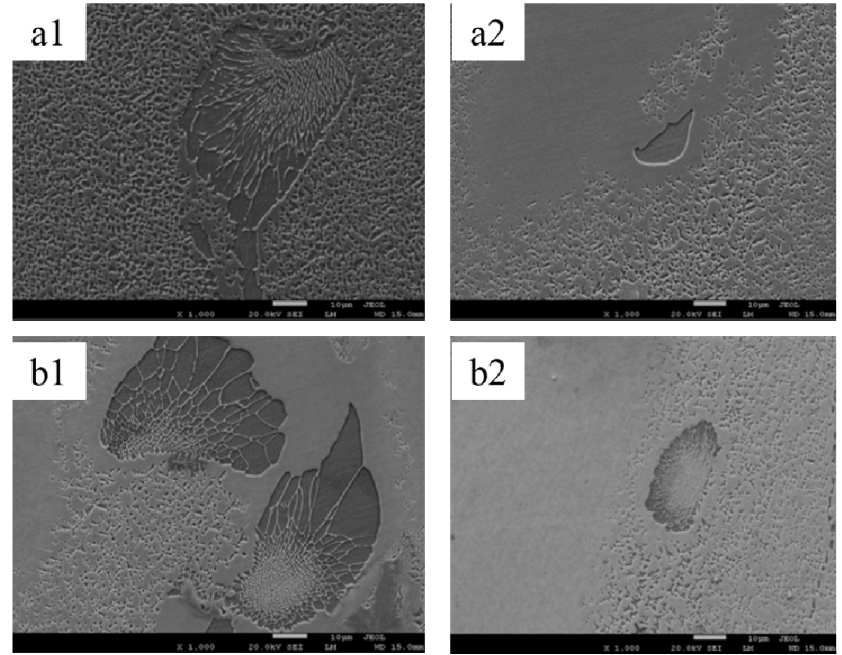
Figure 7. Scanning electron microscopy (SEM) image revealing the morphology of γ - γ ’ eutectic of directionally solidified superalloy at a temperature gradient of 80 K·cm − 1 , drawing speed of 10 μ m·s − 1 : ( a1 ) 0 T, diameter of 4 mm; ( a2 ) 0.5 T, diameter of 4 mm; ( b1 ) 0 T, diameter of 12 mm; ( b2 ) 0.5 T, diameter of 12